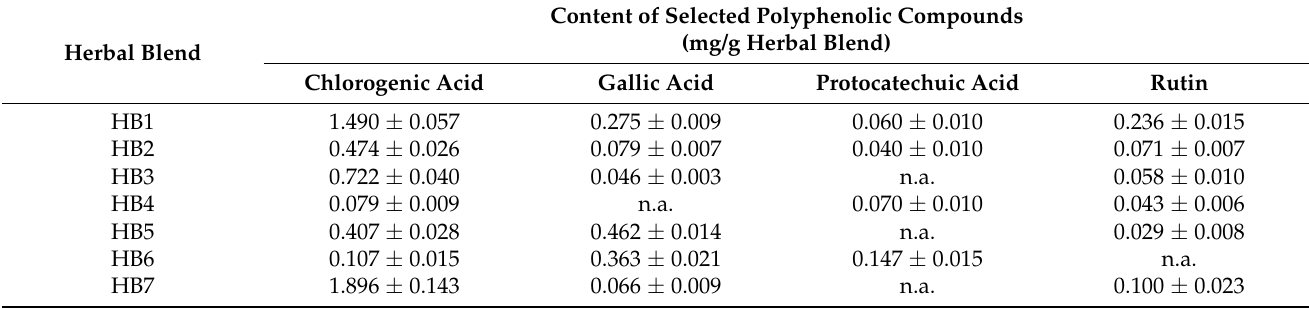
Table 3. Content of selected polyphenolic compounds in herbal